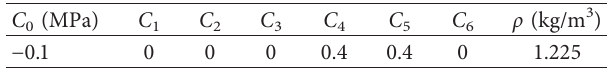
Table 2: Material model and EOS parameters of air [20, 34,